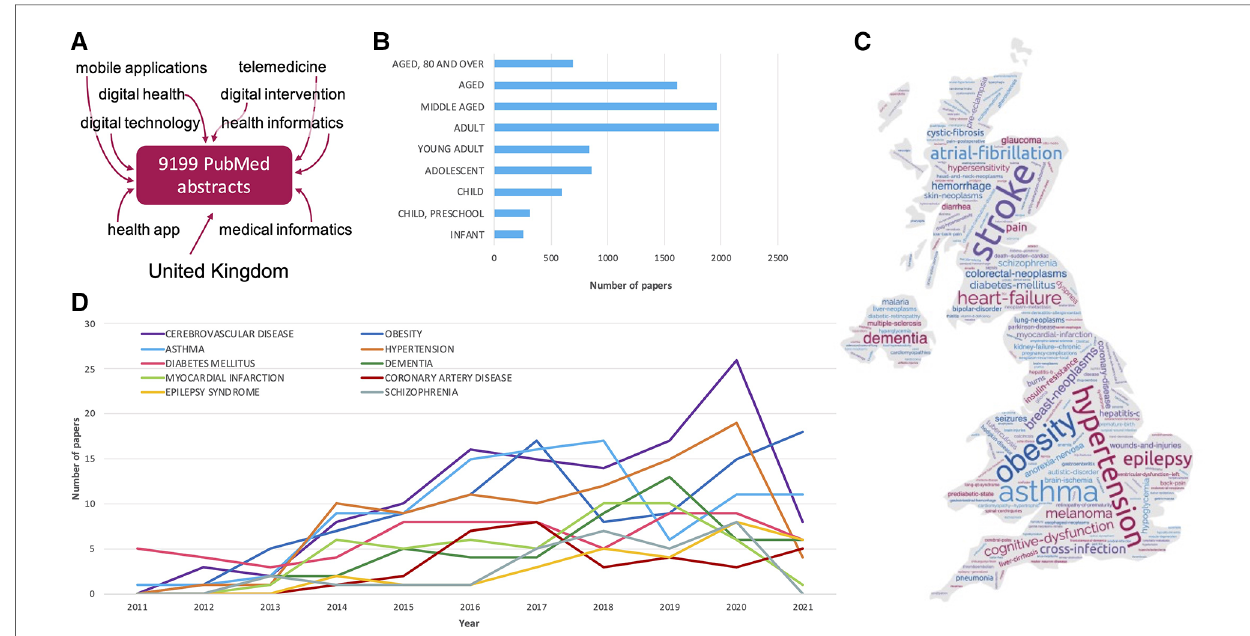
FIGURE 1 Mining PubMed records for disease-related association with digital-health related publications. ( A ) Terms used to search PubMed for digital health related publications. ( B ) Number of papers associated with different age groups. Age group de fi nitions are derived from MeSH as follows: Infants 1 to 23 months; Child, preschool: 2 – 5 years; Child: 6 – 12 years; Adolescent: 13 – 18 years; Adult: 19 – 44 years; Middle aged: 45 – 64 years; Aged: 65 – 79 years; Aged, 80 and over: 80 years or over. ( C ) Word cloud of the disease terms found in PubMed records associated with digital health; the size of the word corresponds to the number of times it was mentioned across abstracts. The locations of the words on the map do not represent a link to speci fi c UK regions. ( D ) Longitudinal counts of the most prevalent diseases (within the analysed corpus), over the last 11